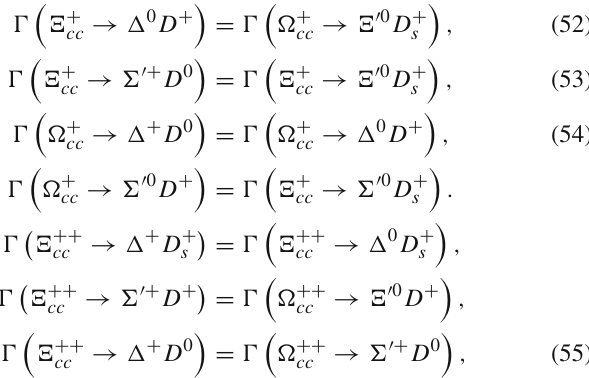
Table 8 Doubly charmed baryons decays into a light baryon in the decuplet and a charmed meson